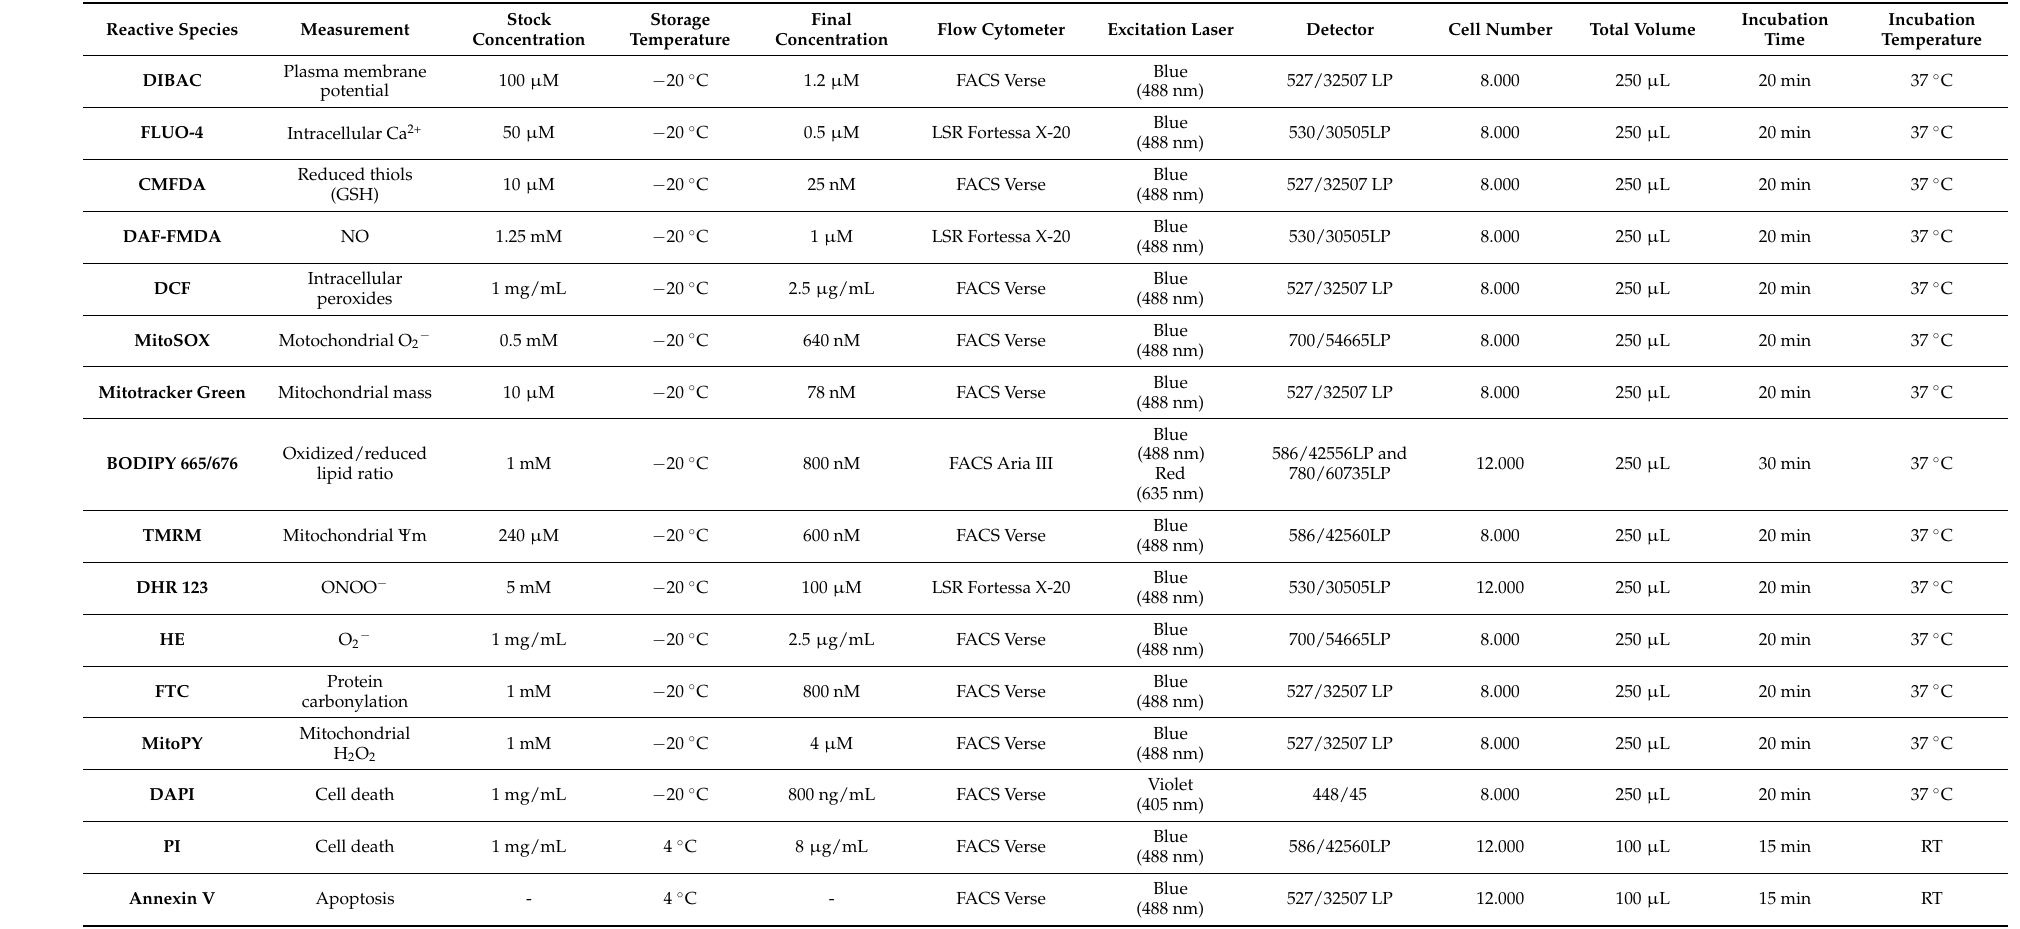
Table 1. Summary of the flow cytometry